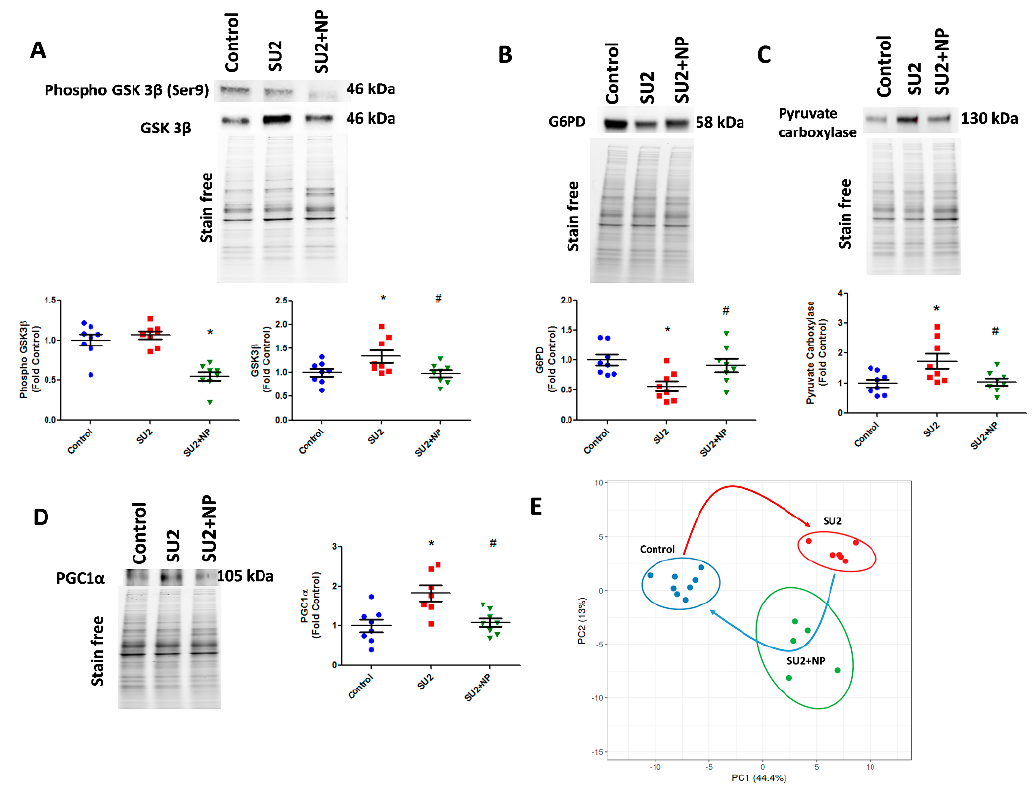
Figure 6. NP maintained the glycolytic shift in early PAH. ( A ) Western blot of phospho GSK3 β and GSK3 β in SU2 and SU2 + NP treatment. Sugen / hypoxia-induced increase in GSK3 β expression was reduced with NP treatment. ( B ) Decreased G6PD expression in SU2 was upregulated significantly with NP treatment. ( C ) Increased pyruvate carboxylase expression was decreased with NP treatment. ( D ) Mitochondrial biogenesis marker PGC1 α expression found increased in SU2 was significantly reduced with NP treatment. Data expressed as mean ± SE, N = 6–8, * p<0.05 versus control, # p < 0.05 versus SU2 by ANOVA. ( E ) Metabolite analysis of lung lysate showed metabolic reprogramming in SU2 group and attenuation of metabolic changes by NP treatment. Principal component 1 (PC1) and principal component 2 (PC2) plots explained 44.4% and 13% of the total variance, respectively. Prediction ellipses for control, SU2, and SU2+NP groups show a probability of 0.95 that a new observation from the same group will fall inside the ellipse. N = 19 data points. 4. Discussion Pulmonary arterial hypertension (PAH) is a progressive and fatal condition characterized by narrowing of the pulmonary arteries because of muscular thickening and intimal proliferation [23]. Abnormal Akt activation causes normal cells to undergo proliferative conversion [24], but in PAH, the cause and activation of Akt are not fully elucidated. The nitration of Akt plays a crucial role in its activation, and we found increased Akt nitration in patients with PAH as well as in the sugen/hypoxia model. Akt nitration can activate eNOS phosphorylation, and this, in turn, increases peroxynitrite formation, nitrosative stress, and mitochondrial dysfunction. Prolonged mitochondrial dysfunction is responsible for PAH development with vascular damage and metabolic disorder [6,7]. The study of metabolic alterations can be performed either by metabolomics or proteomics analyses. In our present study, we followed protein expression and compared metabolite profiles between groups. This approach clearly demonstrated PAH-specific alterations in the metabolic enzymes and